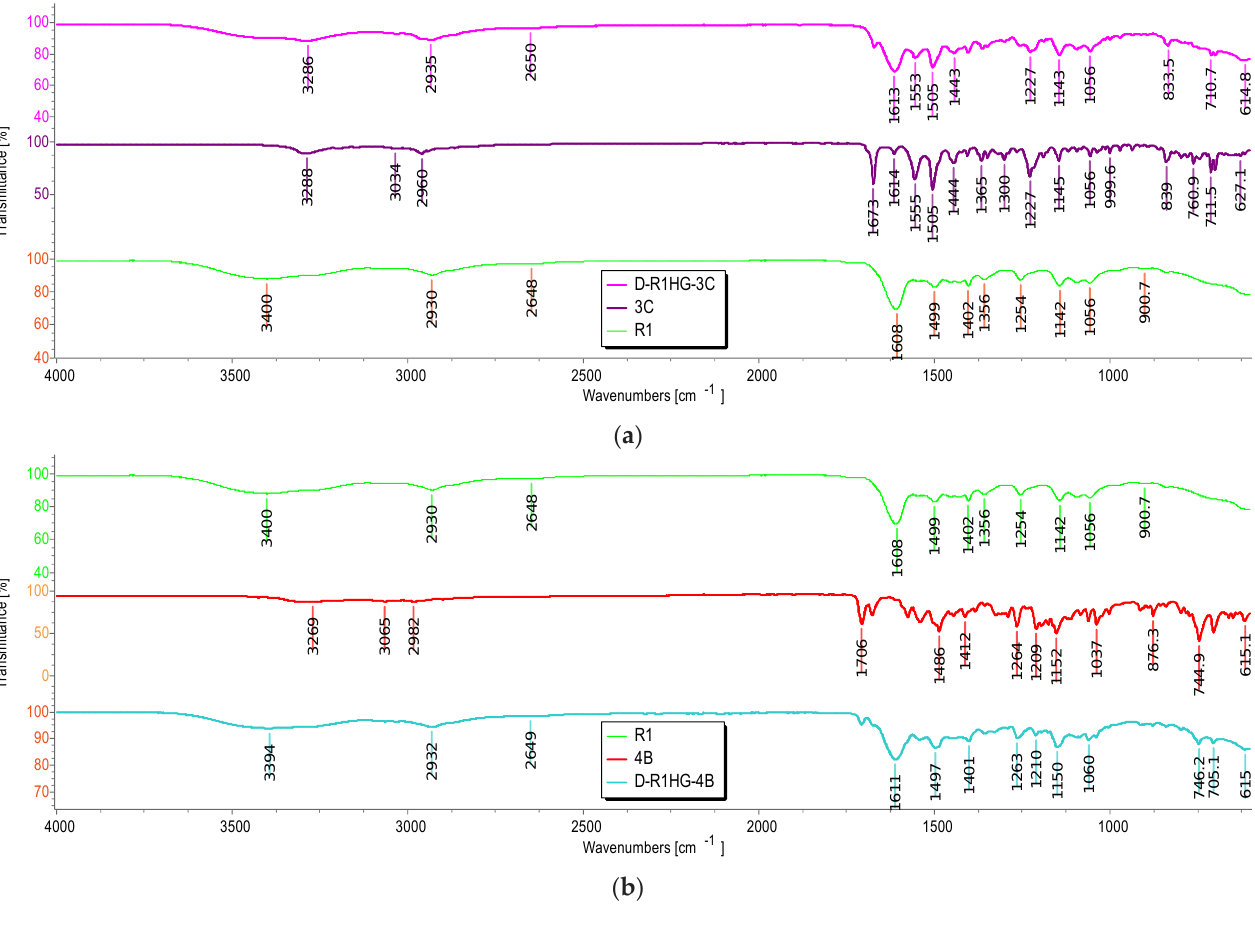
Figure 7. ATR-FTIR spectra of D-R1HG-3c, 3c , and R1 ( a ) and of D-R1HG-4b, 4b , and R1 ( b ). Particularly, in the spectrum of the dried D-R1HG-3c, bands deriving from R1 were observable at 2958, 2935 (CH stretching of methylene groups), 2650 cm − 1 , and at 1613 cm − 1 , (C=O stretching of the amide group of DMAA and AAEA) (Figure 7a). Additionally, bands of the main functional groups of 3c including a weak and large band at 3286 cm − 1 (OH and aromatic CH stretching), bands at 3061, 3030 cm − 1 , a weak band at 1671 cm − 1 (C=O stretching of ureic group), and several other bands typical of 3c at 1553, 1505, 1443, 1227, 1143, 1055, 834, and 711 cm − 1 (aromatic C=C and C-N stretching) characterized the spec- trum of D-R1HG-3c. It was also evidenced that the interactions of 3c-R1-H 2 O that occurred during gel formation did not affect the main functional groups of 3c and R1. A similar scenario was observable in Figure 7b, where additional bands at 1706 and 1707 cm − 1 were visible in the spectra of 4b and D-R1HG-4b, respectively, due to the C=O stretching of the ester group of 4b . Figure 8. ATR-FTIR spectra of D-R1HG-3c and D-R1HG-4b. Principal Components Analysis (PCA) of the ATR-FTIR Data